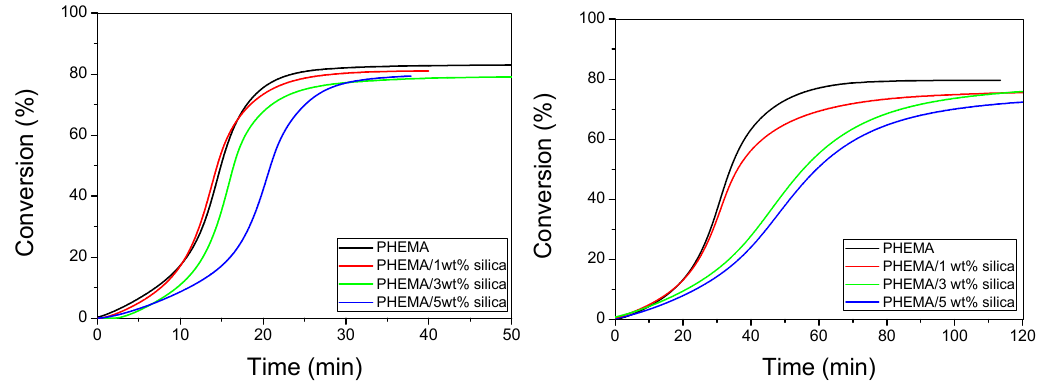
Figure 9. Effect of the amount of nano-silica on the variation of polymerization rate ( a ) and conversion ( b ) with time during polymerization of HEMA at 82 °C.